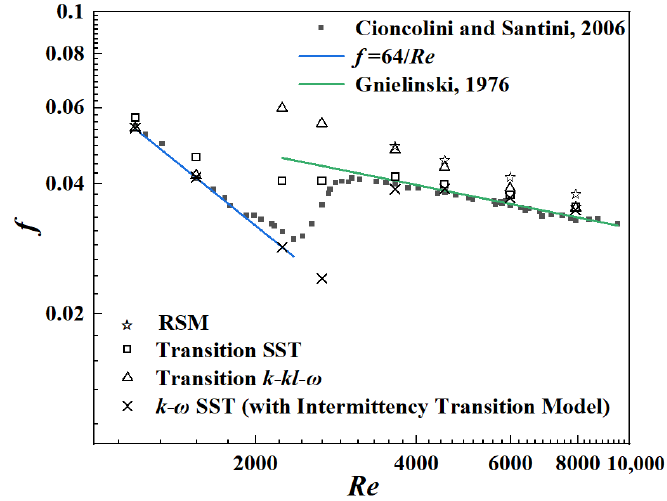
Figure 6. Transition model validation.